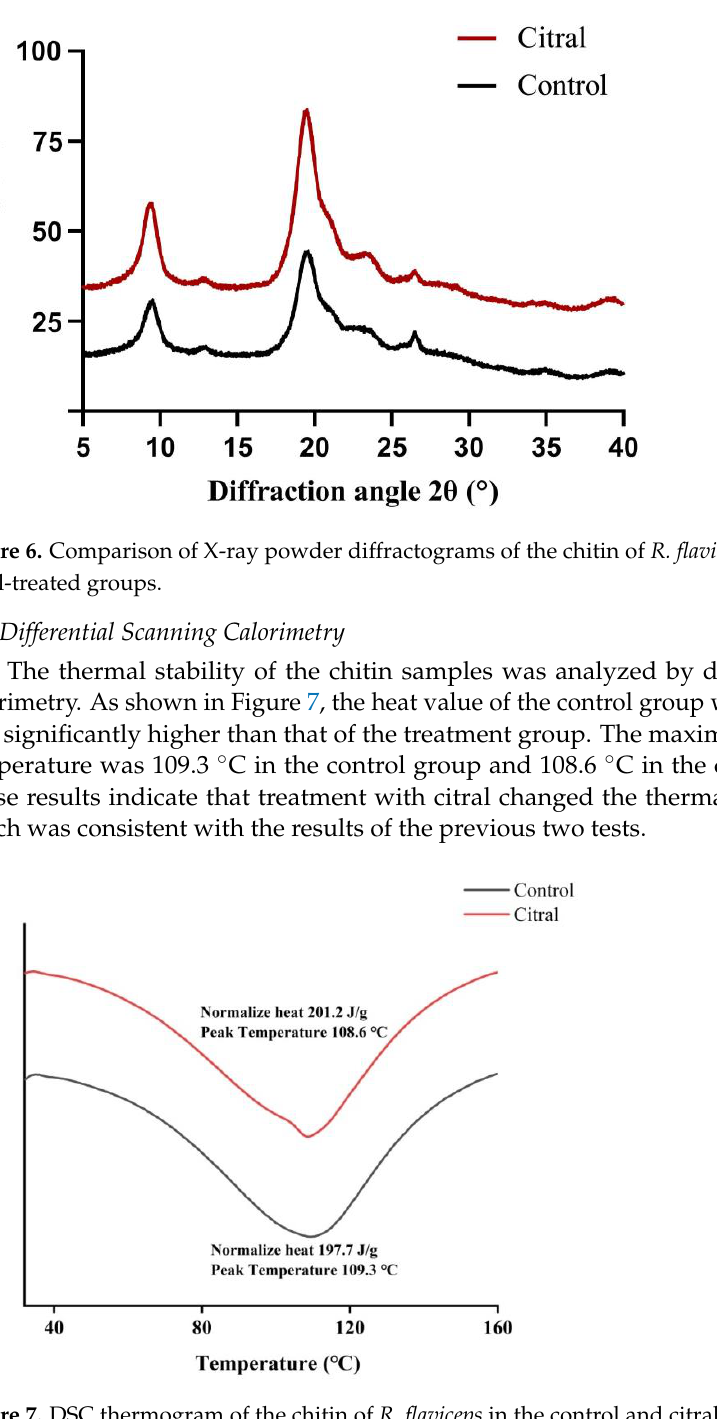
Figure 7. DSC thermogram of the chitin of R. flaviceps in the control and citral-treated groups.